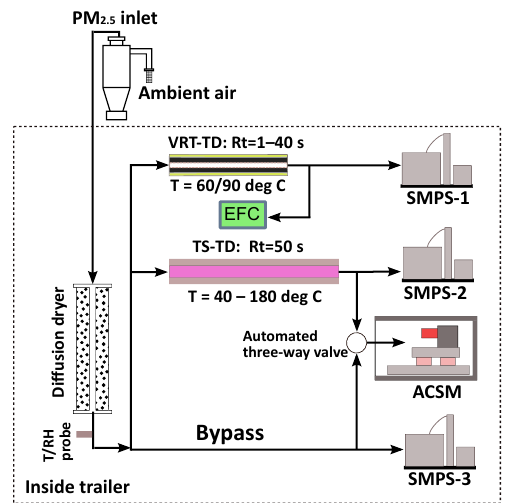
Figure 1. Dual-thermodenuder aerosol volatility measurement setup used during field campaigns at two sites in the southeast- ern US. TS-TD: temperature stepping TD, VRT-TD: variable resi- dence time TD, Rt: residence time, EFC: extra flow control, ACSM: aerosol chemical speciation monitor, SMPS: scanning mobility par- ticle